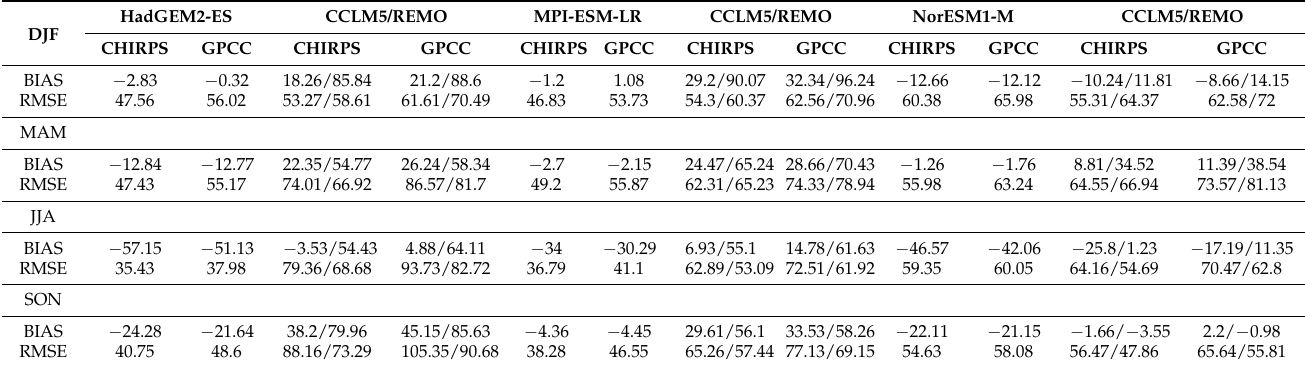
Table 2. Spatial statistics averaged over the whole African domain, considering land grid points. The statistics are provided in mm/month.